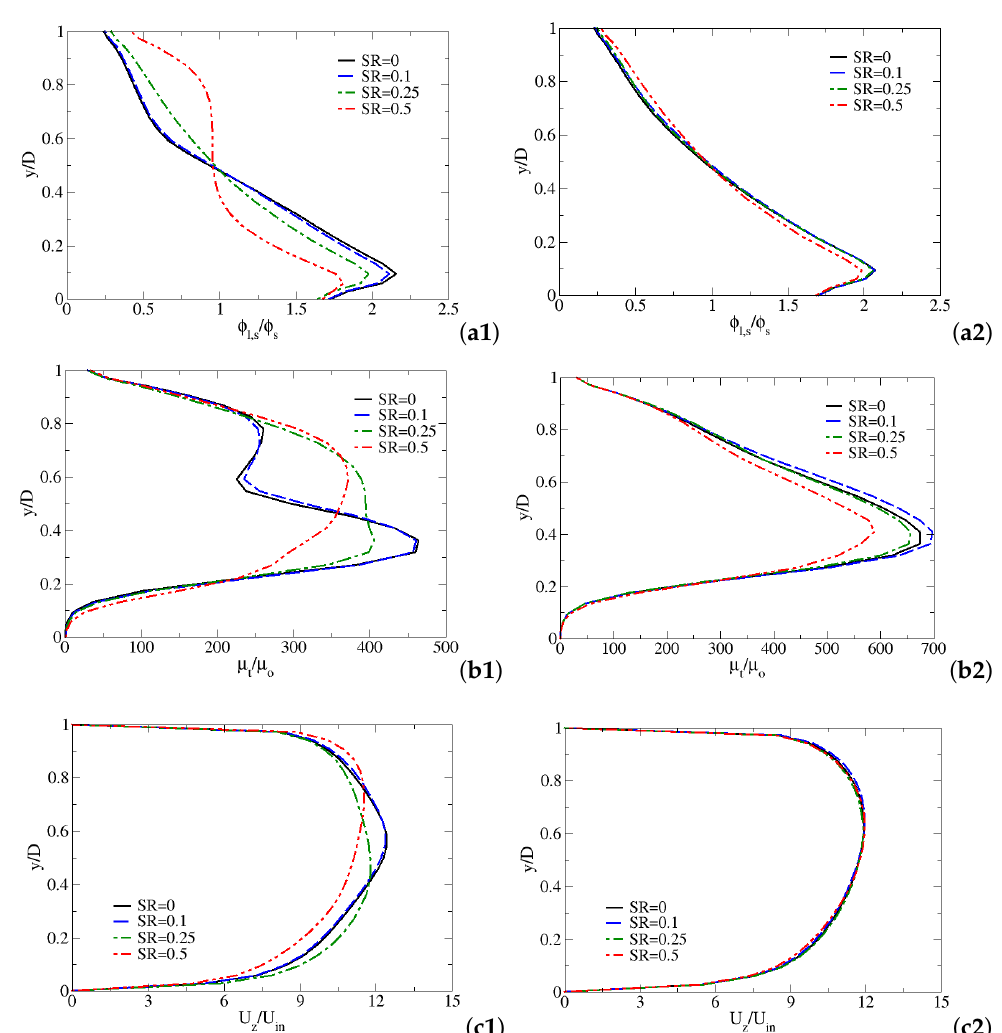
Figure 9. Predicted CFD profiles along r/D for SR = 0–0.5: mixture solid volume fraction at z/D = 35 ( a1 ) and z/D = 55 ( a2 ), turbulent viscosity ratio at z/D = 35 ( b1 ) and z/D = 55 ( b2 ) and z -axial velocity magnitude at z/D = 35 ( c1 ) and z/D = 55 ( c2